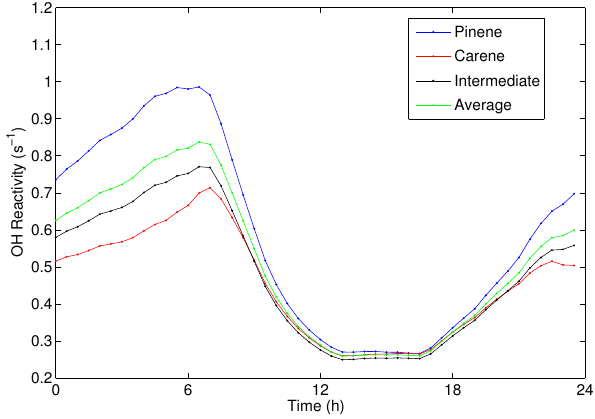
Figure 2. Average modelled (MEGAN 2.04) diurnal profiles of OH reactivity at 14m for the summer of the year 2007 for the four chemotype scenarios (see Table 1 and Fig.